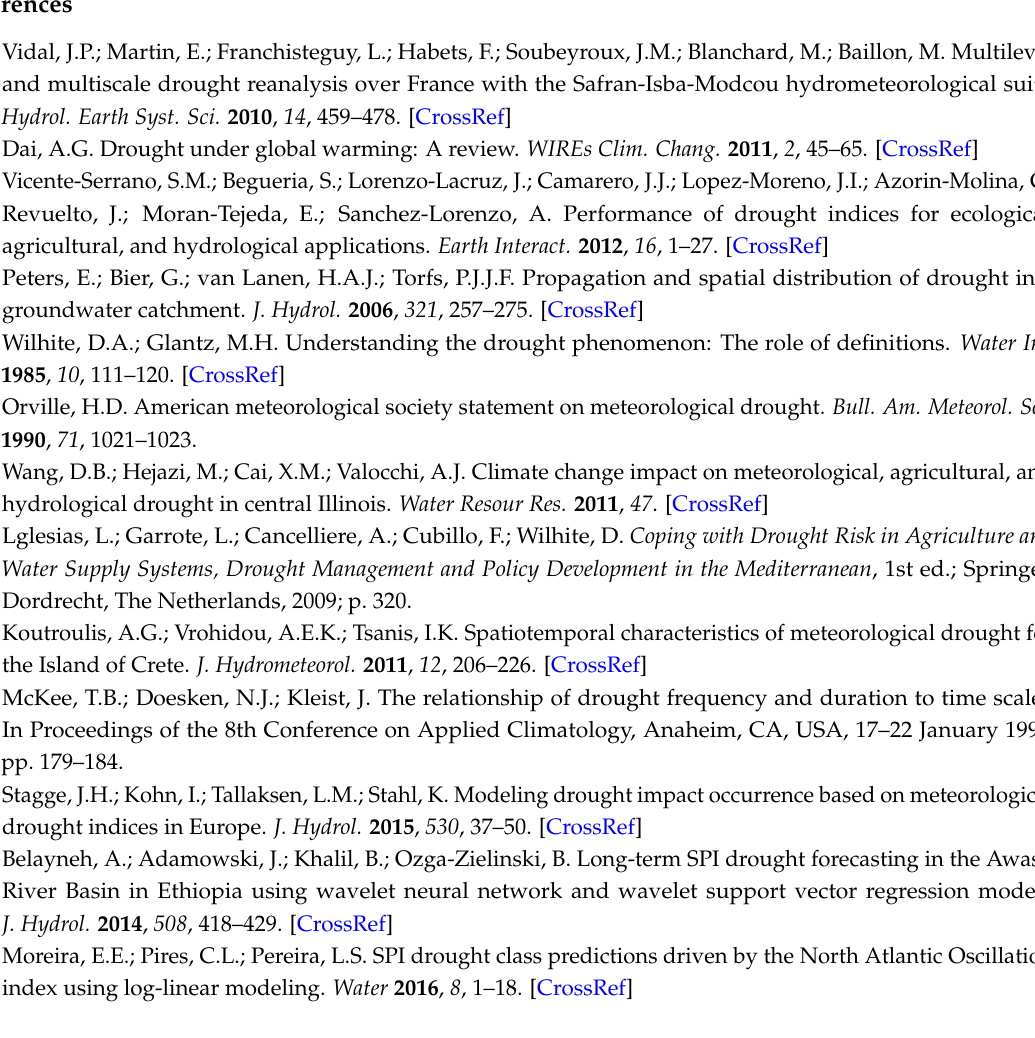
Figure S1: Evolution of SPI over different time scales in three catchments of KRB; Figure S2: The future heat map of (a) meteorological, (b) hydrological, and (c) agricultural droughts in RCP2.6 scenario in three catchments of KRB; Figure S3: The future heat map of (a) meteorological, (b) hydrological, and (c) agricultural droughts in RCP8.5 scenario in three catchments of